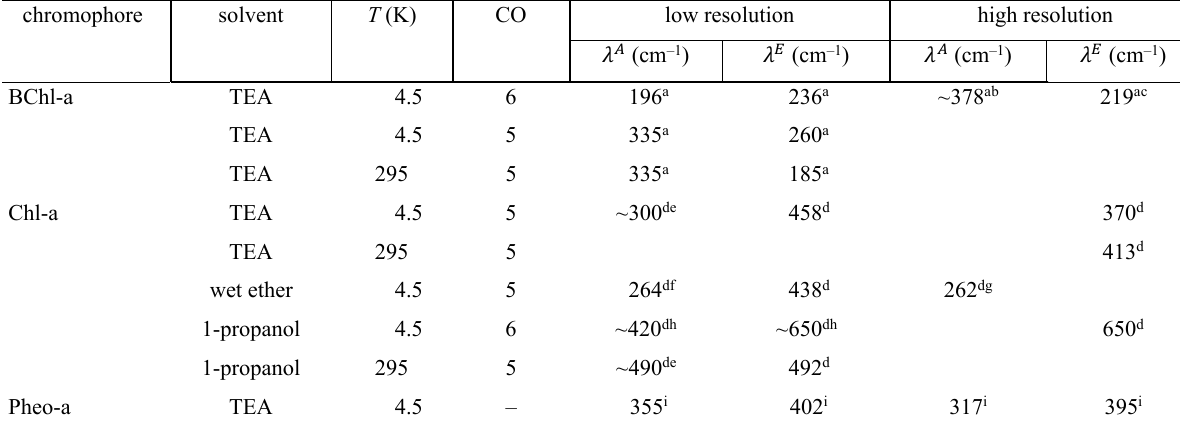
Table 1. Observed emission and absorption reorganization energies for BChl-a, Chl-a, and Pheo-a in various solvents at different temperatures supporting different magnesium co-ordination numbers, as interpreted from low-resolution and high-resolution